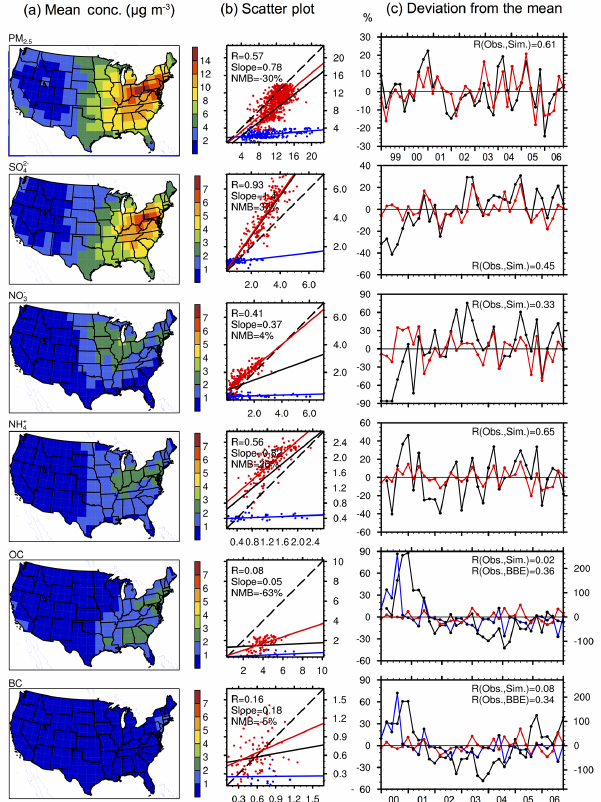
Figure 4. (a) Simulated surface-layer concentrations (µgm − 3 ) of PM 2 . 5 (the sum of SO 2 − , NO − , NH + , BC, and OC) and each 4 3 4 aerosol species averaged over NDJFM of 1999–2006. (b) Scatter plots of the simulated concentrations (µgm − 3 , vertical axis) versus the EPA-AQS observations (µgm − 3 , horizontal axis). Also shown are the y = x line (black dash line), linear fit for whole US (black line), linear fit for western US (blue line), and linear fit for eastern US (red line). The blue and red dots represent sites in the western and eastern US, respectively. (c) Comparisons of the deviation from the mean (DM) of observed concentration (black line) with that of simulated concentration (red line) in each winter month for each aerosol species, left axis. Also shown in the panel for OC (BC) the monthly variation in DM of biomass burning emission of OC (BC), blue line, right